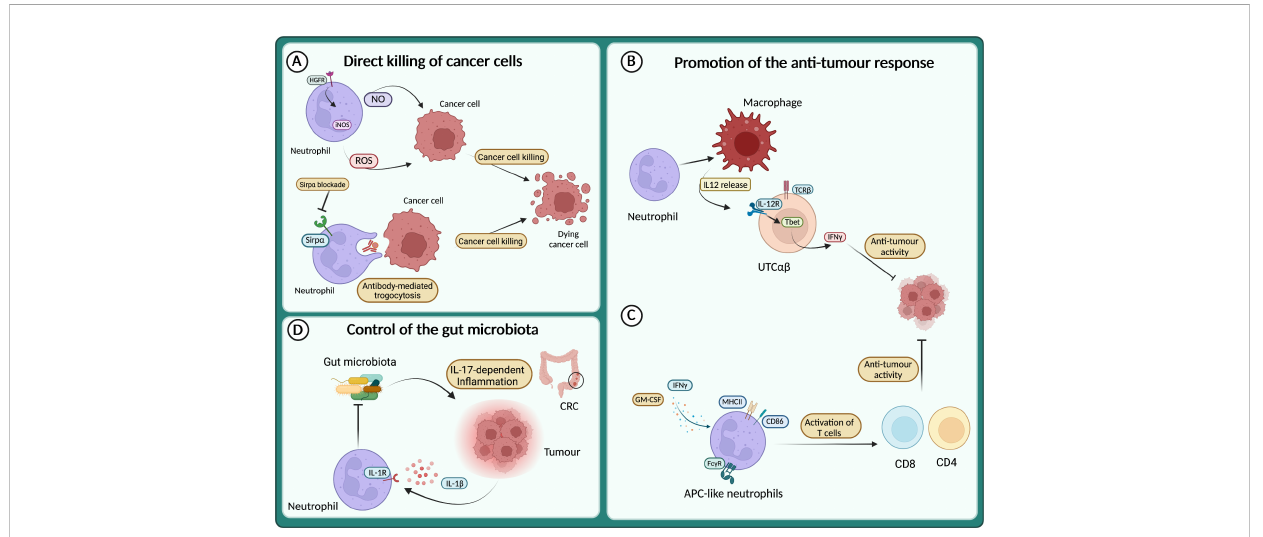
FIGURE 4 Neutrophils in the anti-tumour response (A) Neutrophils directly kill cancer cells through the release of reactive oxygen species (ROS) and NO or via antibody-mediated trogocytosis of antibody-opsonized cancer cells. (B) Neutrophils sustain IL-12 production by macrophages, which in turn activates a subset of unconventional ab T cells (UTC ab ) to produce IFN g and suppress tumour growth. (C) APC-like neutrophils can be induced in response to GM-CSF and IFN g , or by Fc g R-mediated endocytosis of antibody-antigen and can activate T cell anti-tumour response. (D) In response to IL-1 b neutrophils restrict the invasion of gut microbiota and thus dampen microbiota-dependent in fl ammation in the context of colorectal cancer